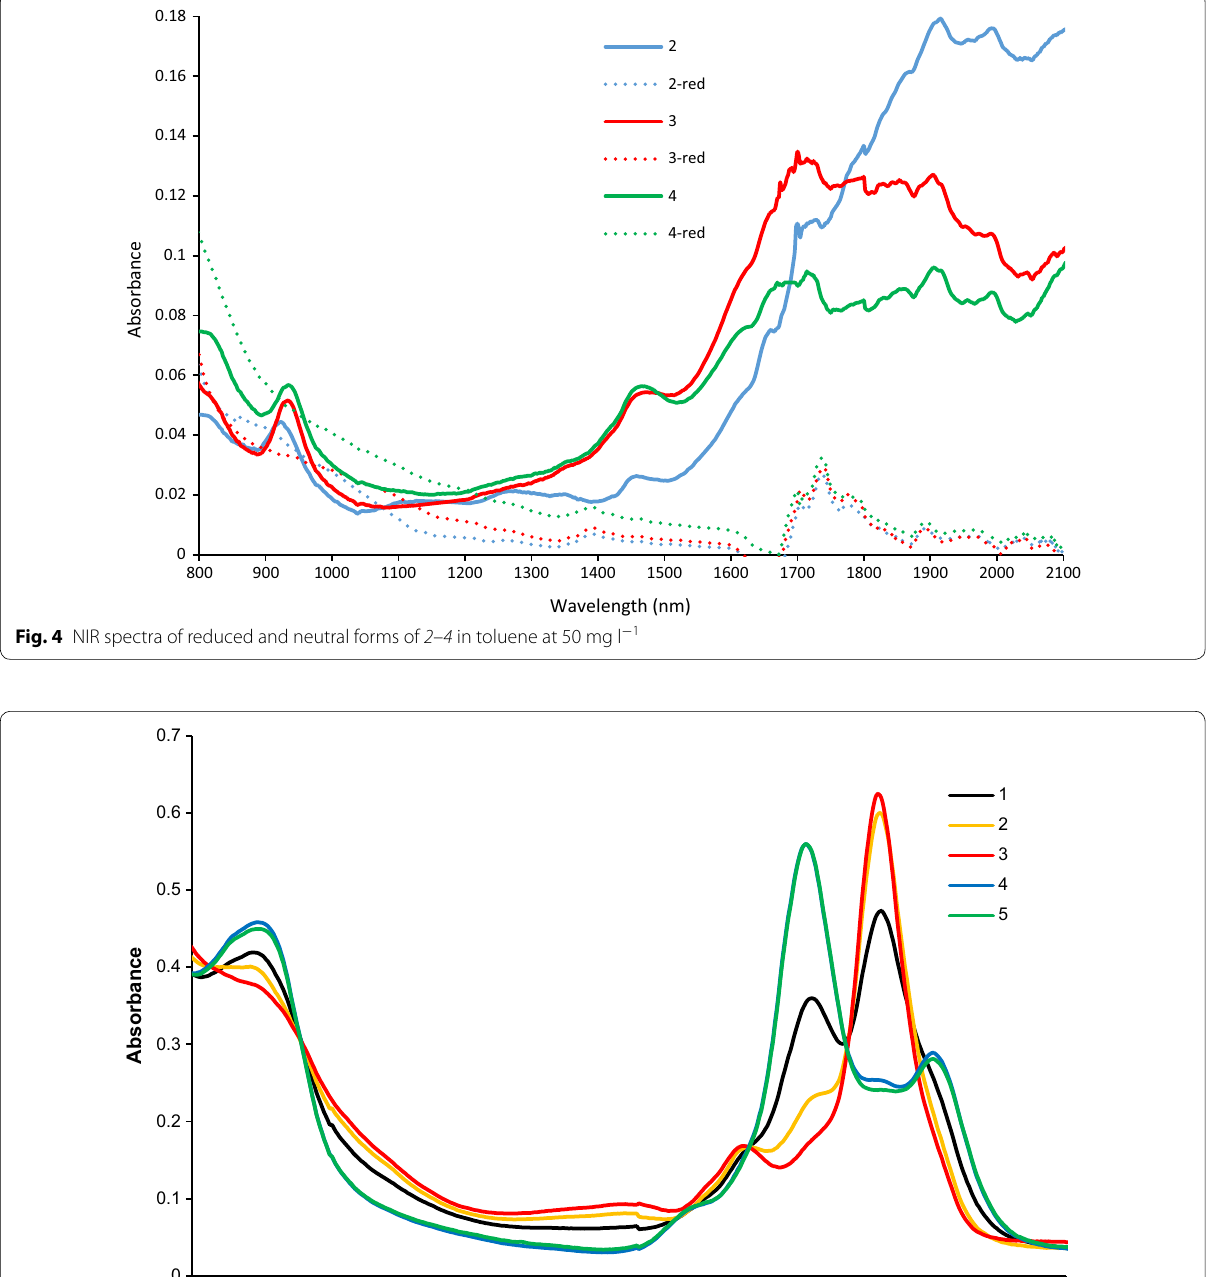
for phthalocyanines and corresponds to the C tion of the benzene ring. The peaks at 1477, 1446, 1382, 1313, 1284, 1198, 1089, 984, 967, 902, 883, 760, 749 and 693 cm − 1 characterize stretching and bending vibrations